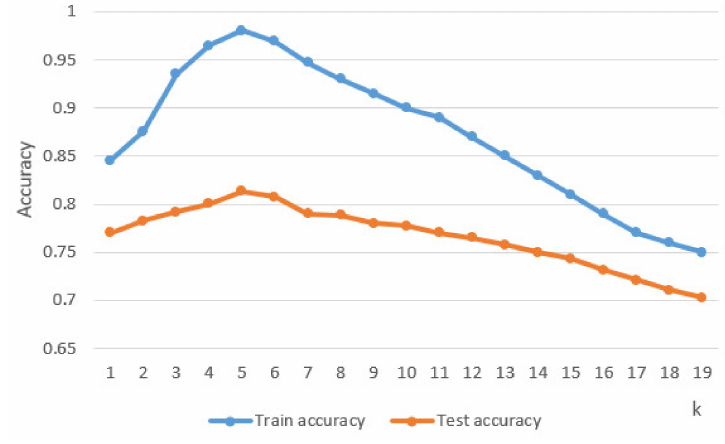
Figure 11. k tuning.